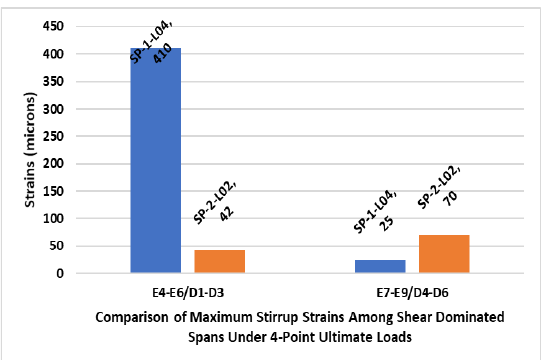
Figure 36. Comparison of maximum stirrup strains recorded for loading setup SP-1-L04 and SP-2-L02 under four-point ultimate loads.